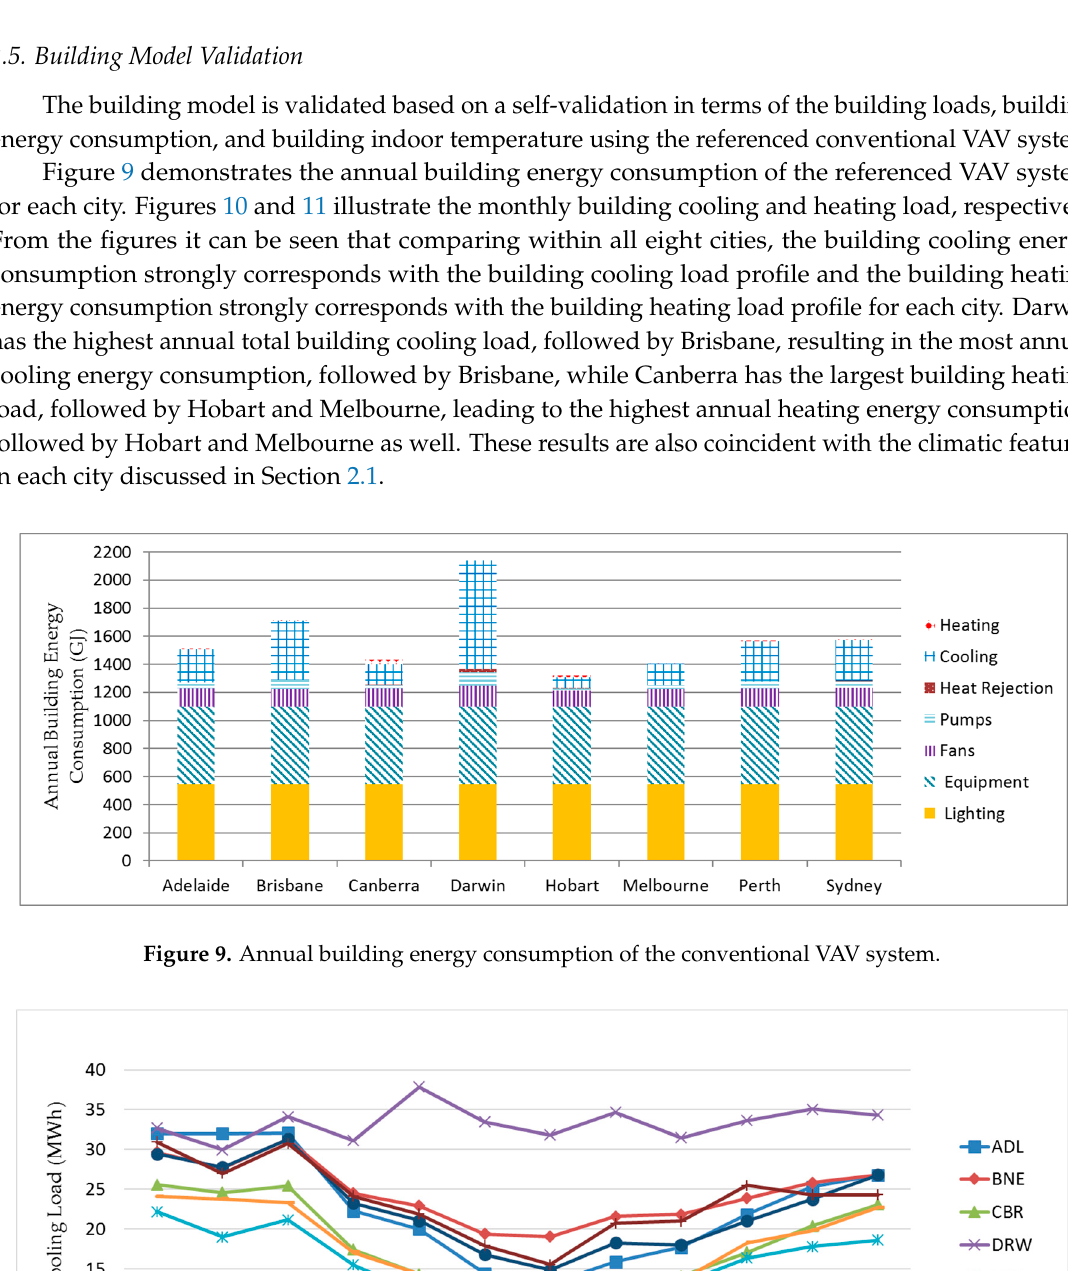
Figure 10. Monthly building cooling load.